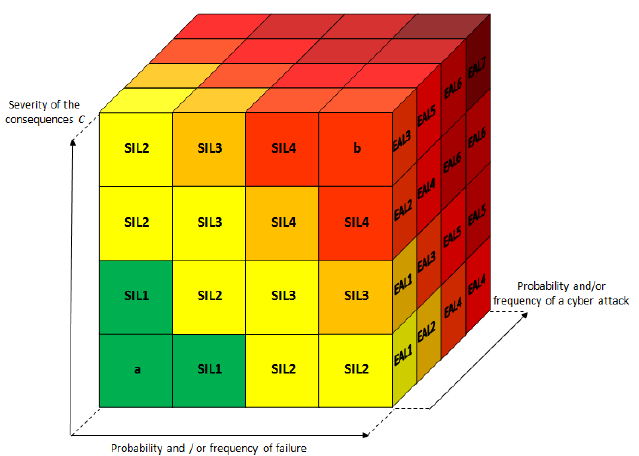
Figure 6. Risk Cube (SIL-EAL).